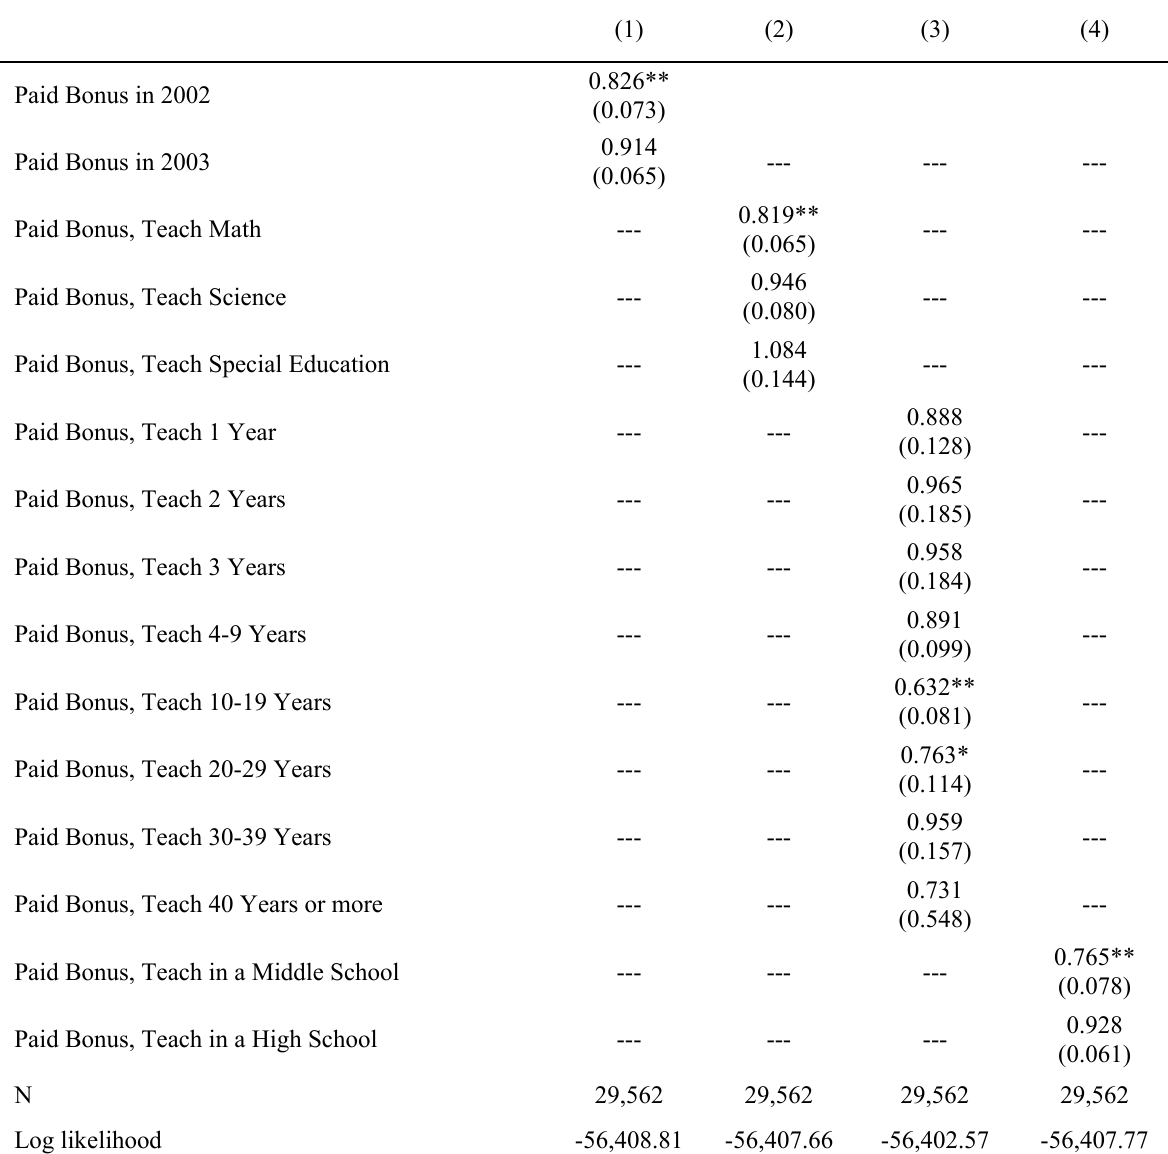
Table 5 : Testing for Heterogeneity in the Program’s